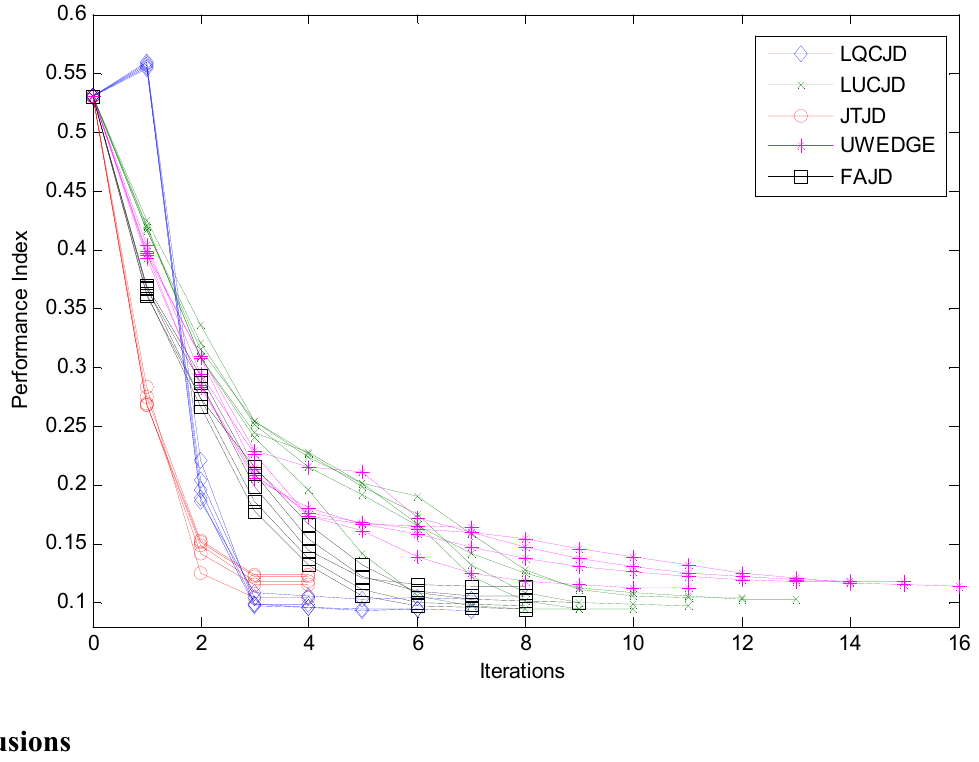
Figure 6. Performance indices of LUCJD, LQCJD, UWEDGE, FAJD, and JTJD versus iterations. SNR is 10 dB, the number of snapshots is 1,000, and the noise is with , ρ ) = (0.5, covariance levels ( ρ 1 2